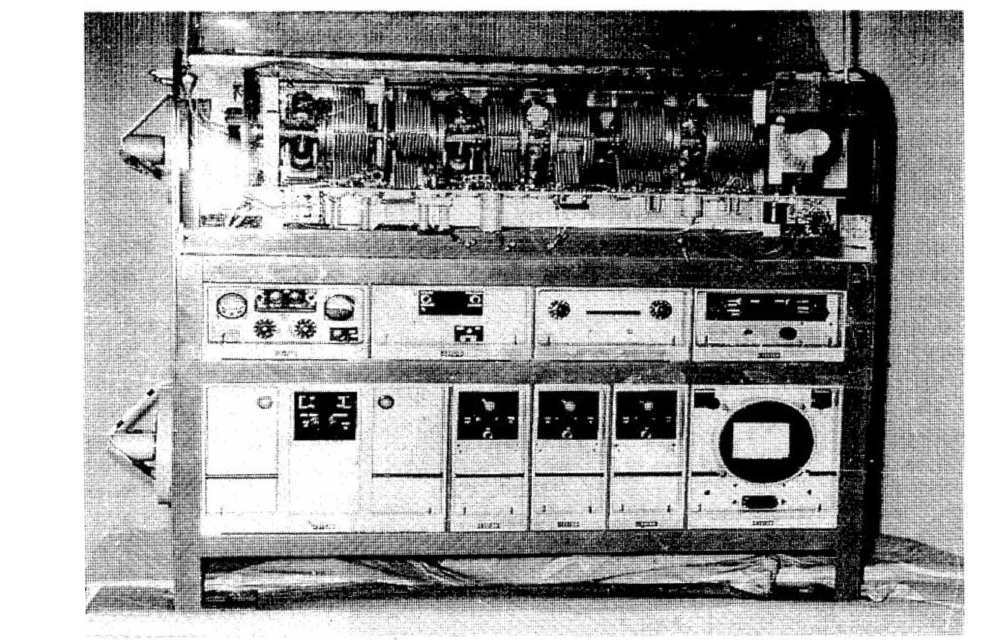
Figure 1. Antique ionosonde still in use during the